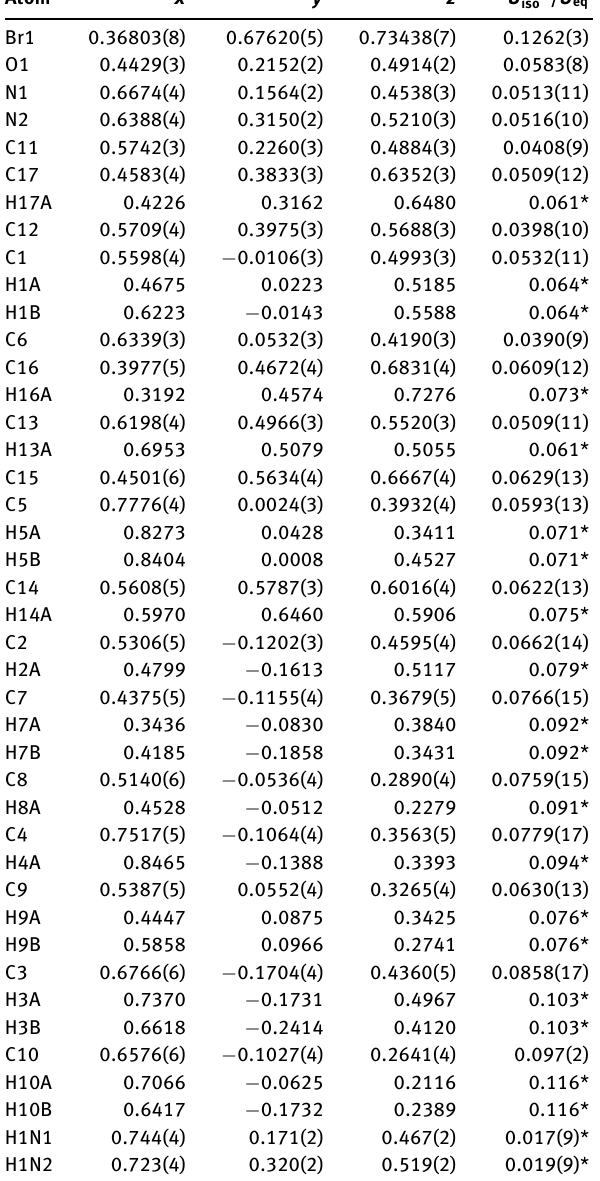
Table 2: Fractional atomic coordinates and isotropic or equivalent isotropic displacement parameters (Å 2